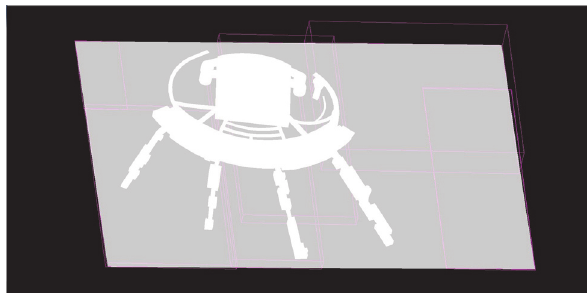
Figure 8. Polyhedron-inner side evaluation for point by using the triangle plane